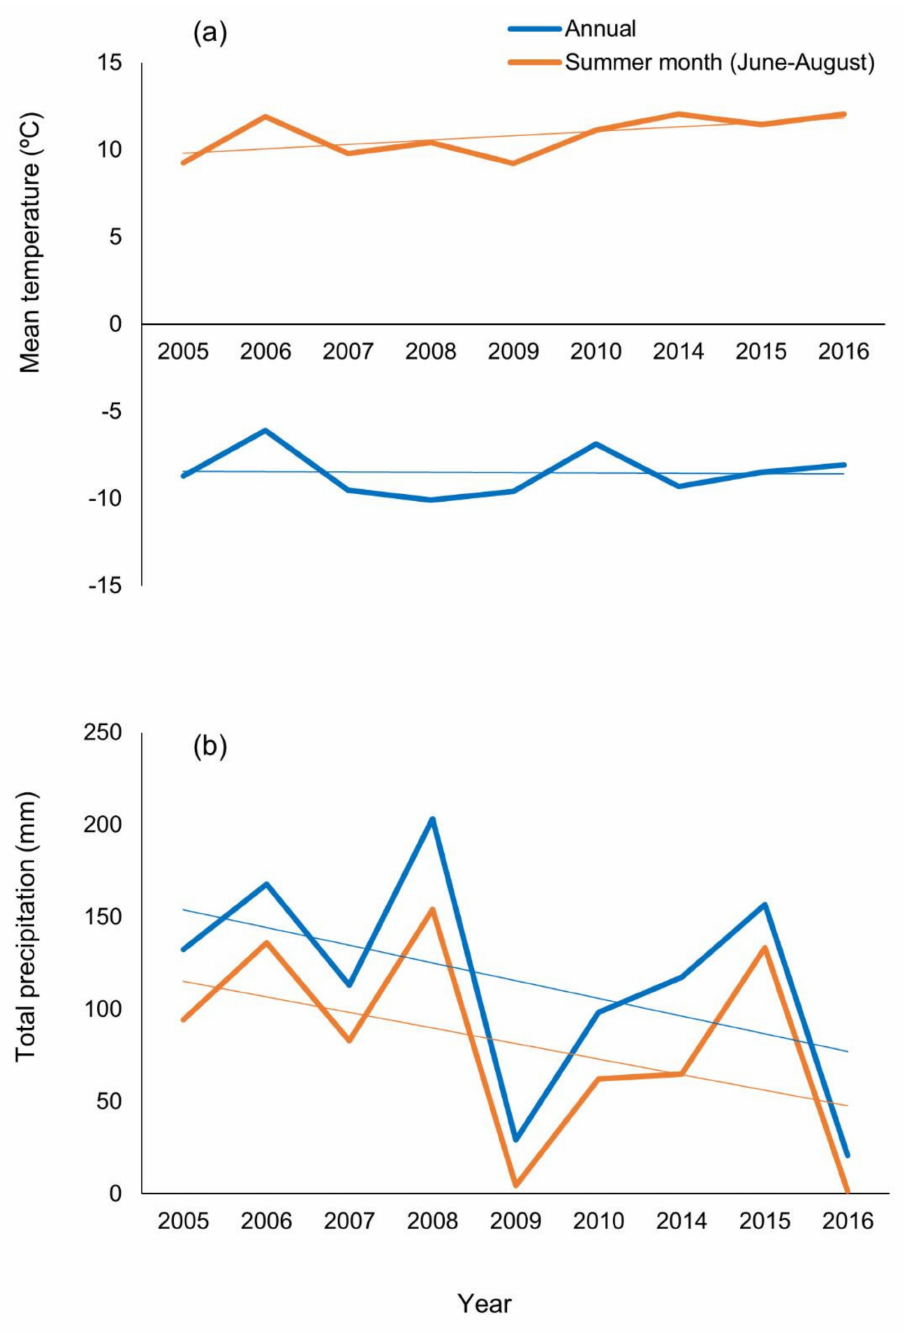
Figure 2. Annual and summer (June–August) ( a ) ambient temperature and ( b ) precipitation from 2005–2016 at the research sites. Water retention differed by substrate, with processed kimberlite holding significantly more water than lakebed sediment and crushed rock at saturation (Figure 3). At field ca- pacity and near dry, lakebed sediment and processed kimberlite did not significantly differ, although processed kimberlite held slightly greater water. Lakebed sediment and processed kimberlite each held more water than crushed rock at all three potentials (Figure 3). Consid- ering the topsoil amendment with substrates, again processed kimberlite had slightly greater water content than lakebed sediment and crushed rock, but none differed